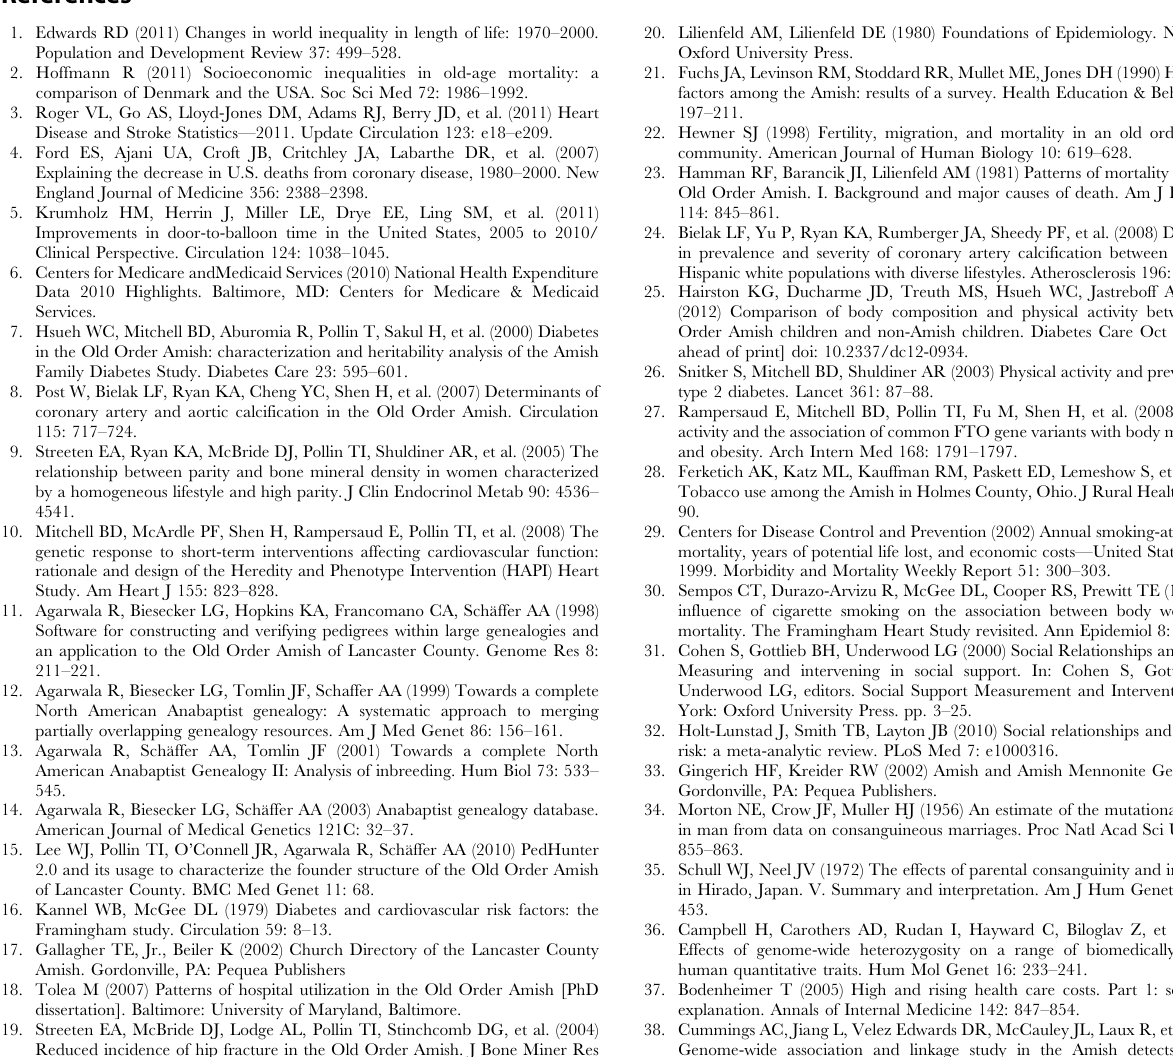
between Old Order Amish and non-Amish whites,